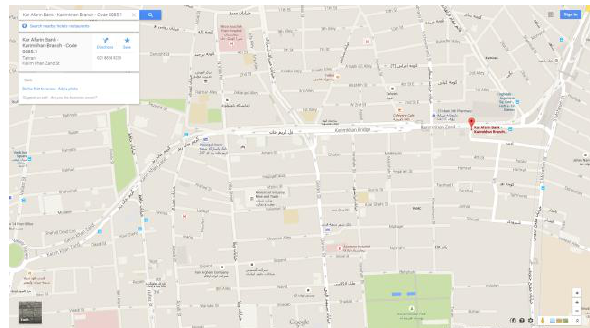
Figure 7. Output of Search Address in Google Maps